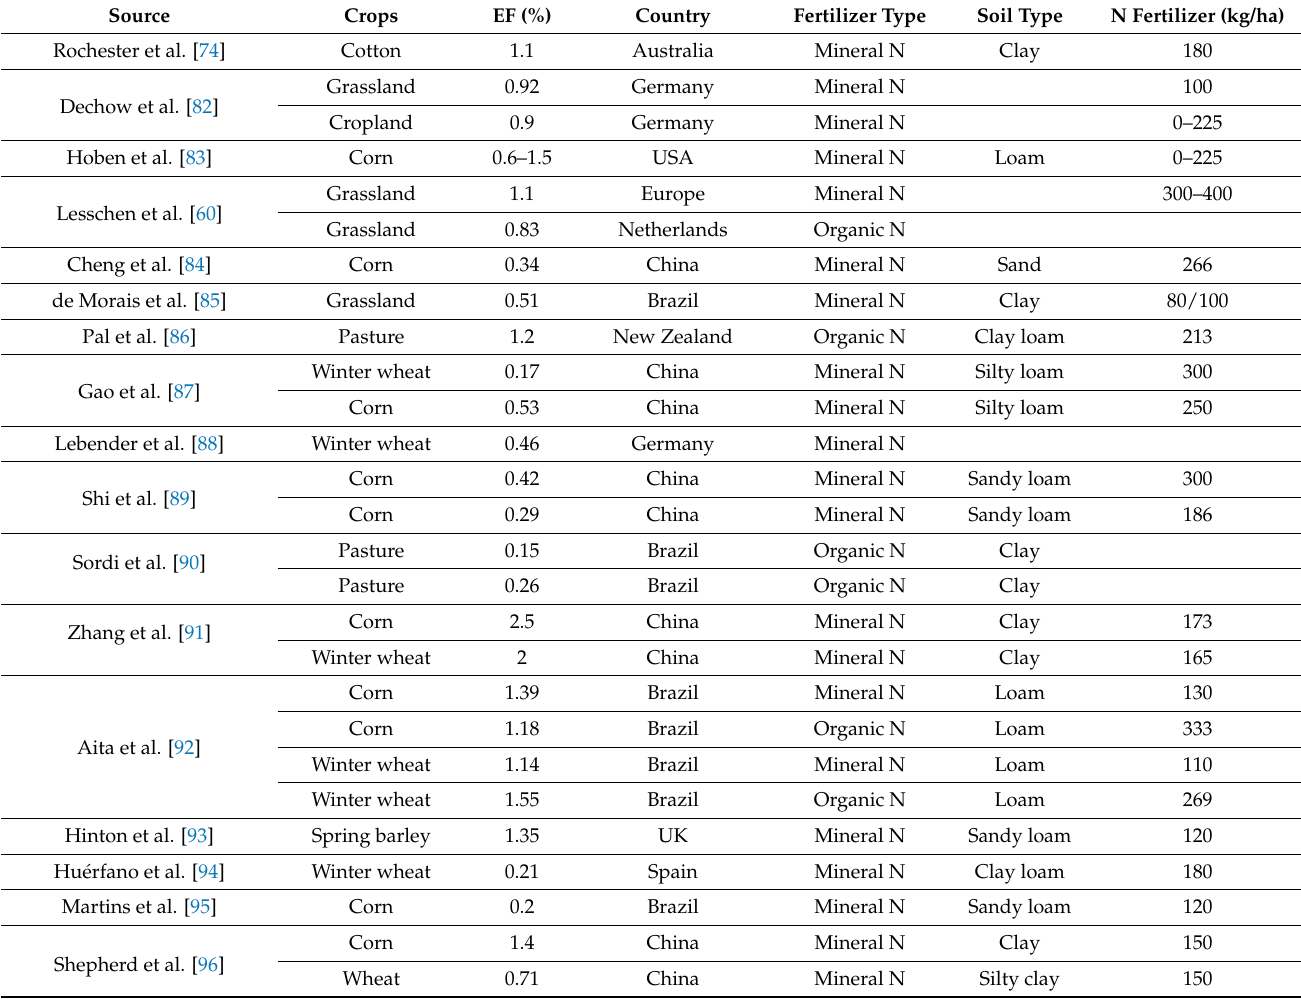
Table 3. The emission factor (EF) for N 2 O as reported in the